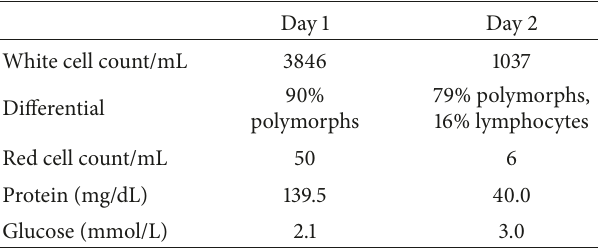
Table 1: CSF composition.